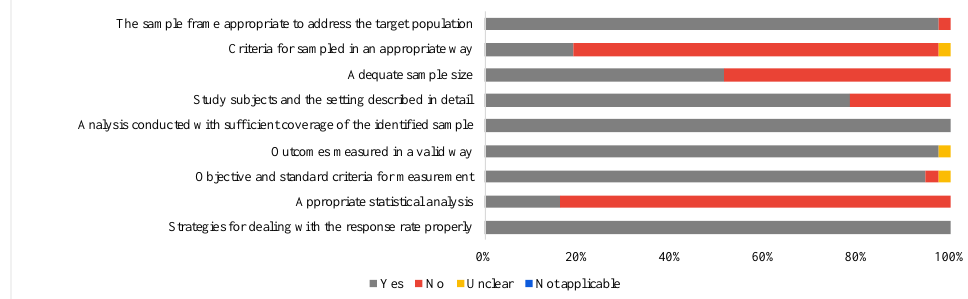
Figure 2. Risk of bias of the included articles according to study design.